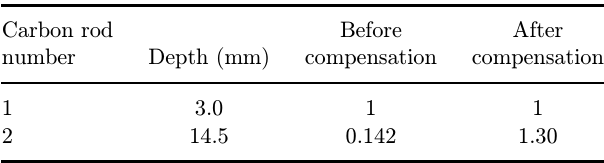
Table 1. Comparison of PA values before and after compensation.